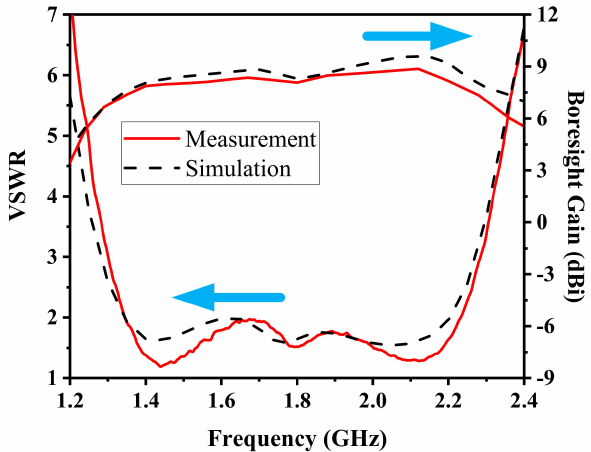
Figure 10. The comparison of simulated VSWR and boresight